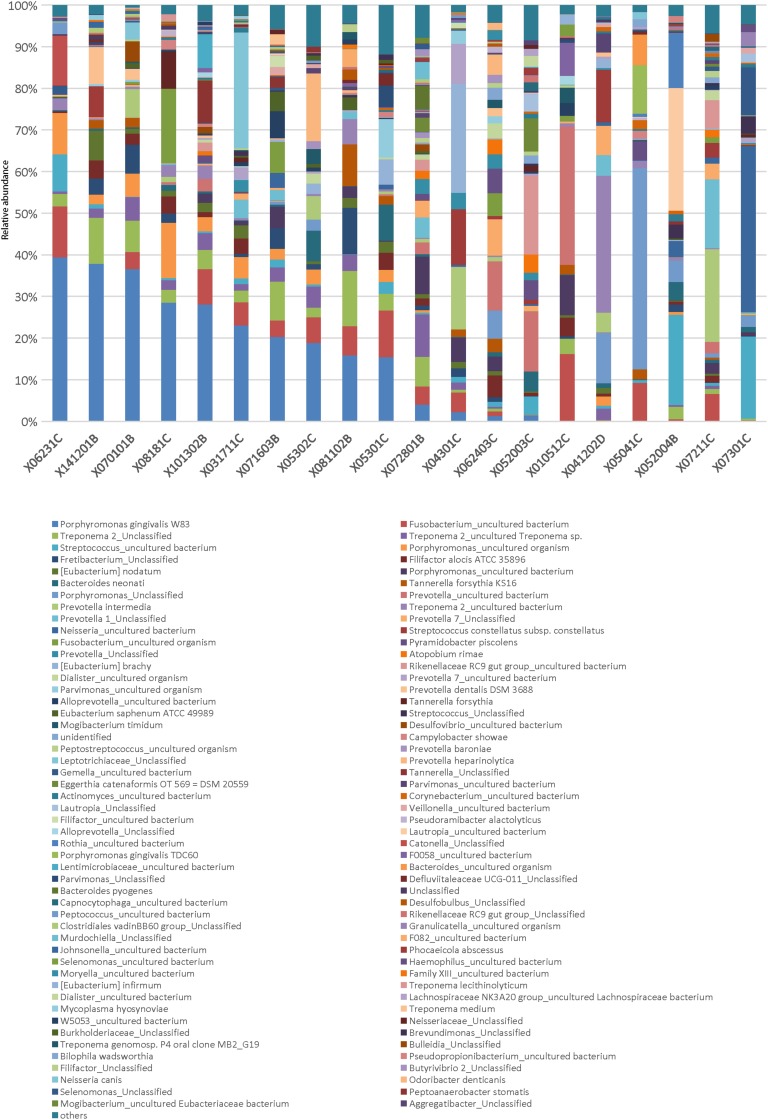
Relative abundance of genera in the AB group. Each column represents a sample in the AB group. The genera were sorted in descending order of average abundance in abscess samples. Different bacterial taxonomies at the genus level are shown in different colors on the bottom. Abundance cutoff in this bar graph was set at 1%; some below 1% were shown as “others.”